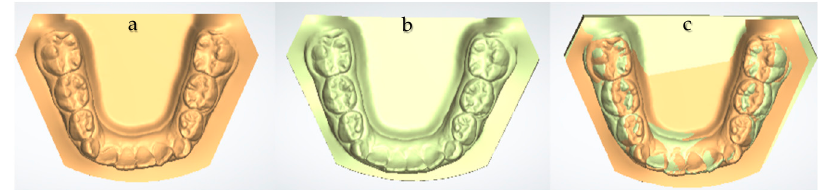
Figure 4. Test Group—Leaf: Mandibular arch before ( a ), after the expansion ( b ) and the superimposition of the two digital casts ( c ).